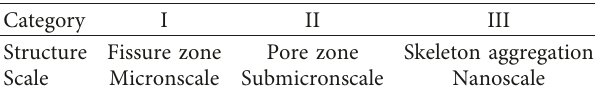
Figure 13: Pore characteristics measured by SEM. Table 6: Zone